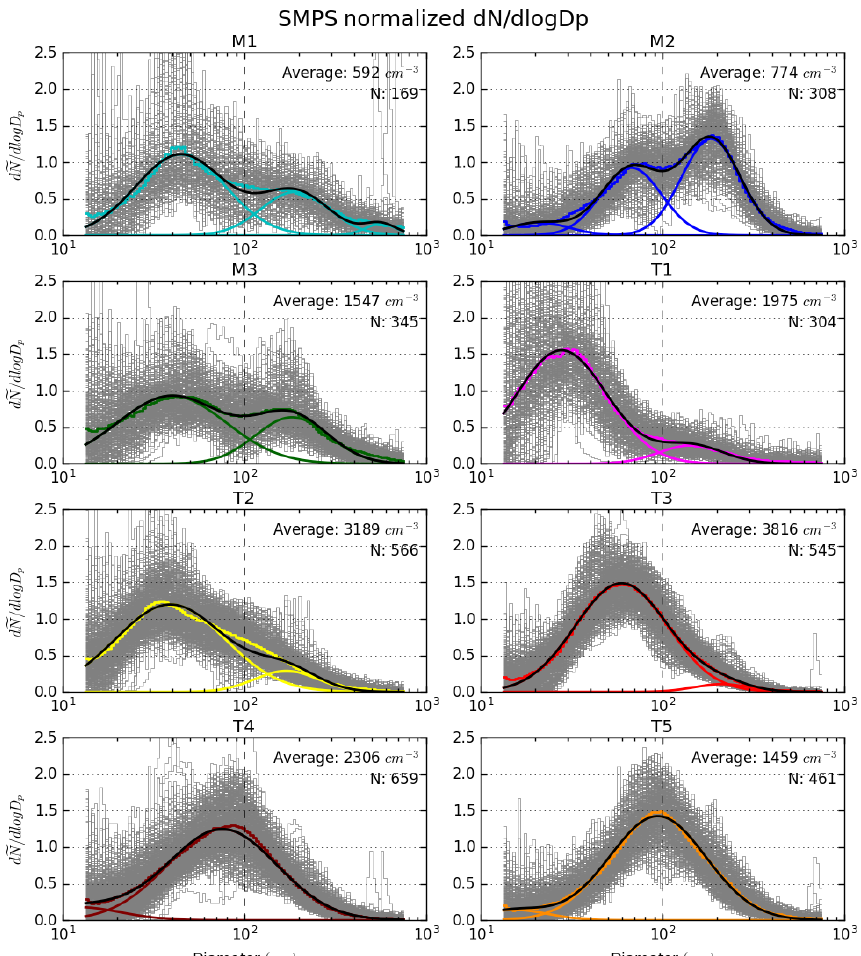
Figure 4. Normalized size distribution for each cluster from the eight-cluster K -means classification. Colored step lines show the average distribution, with best-fit multimodal lognormal fit in black and each mode as colored curves. Observed spectra for each data point in the cluster are shown in grey. Average cluster total particle number concentration and number of data points in each cluster are